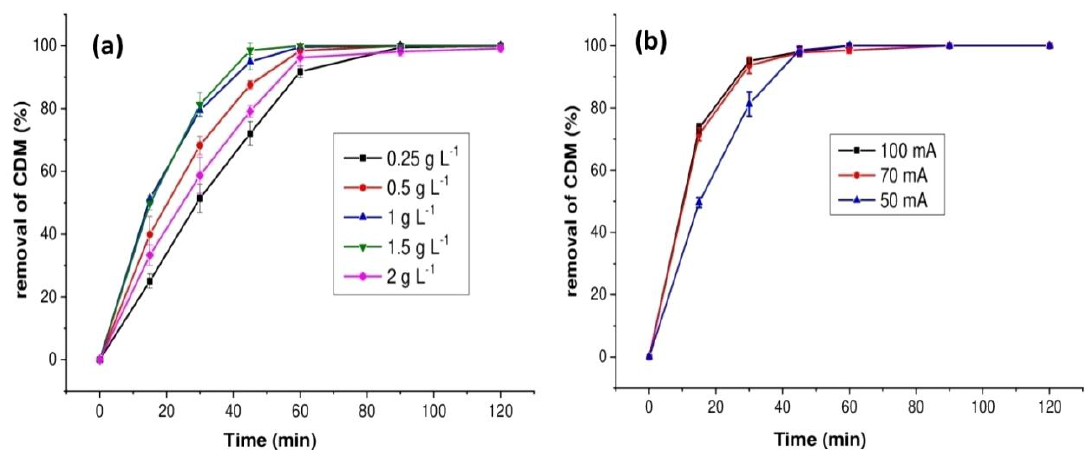
Figure 2. ( a ) Effect of catalyst dosage, ( b ) Effect of current intensity.